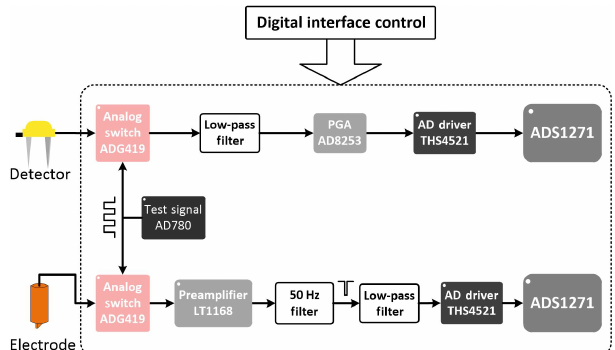
Figure 3. Block diagram of the analog board of the data acquisition